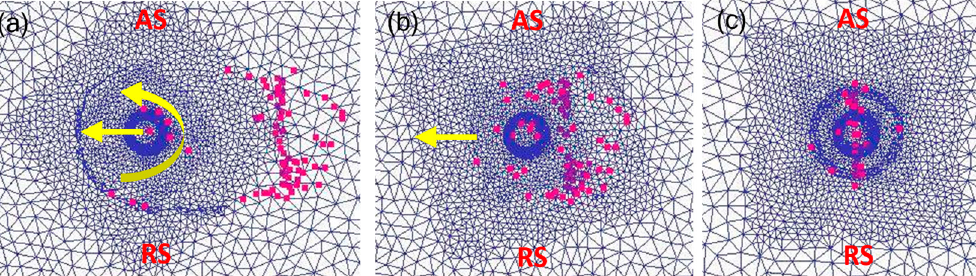
Figure 13. Tracking the distribution of particles. ( a ) The plunging stage; ( b ) particle flow; ( c ) welding end.